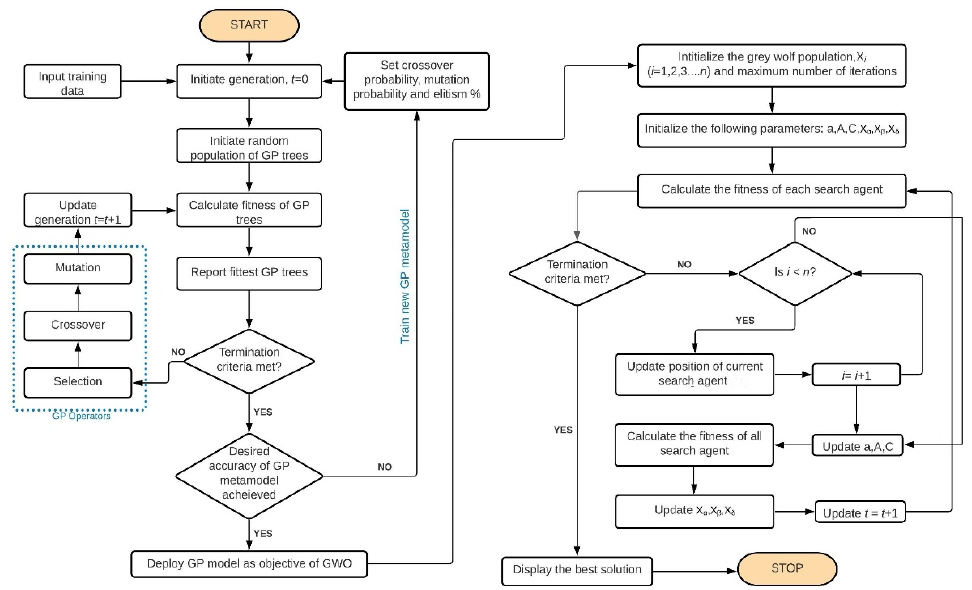
Figure 1. Flowchart for the proposed hybrid genetic programming–gray wolf optimization (GP- GWO) approach.